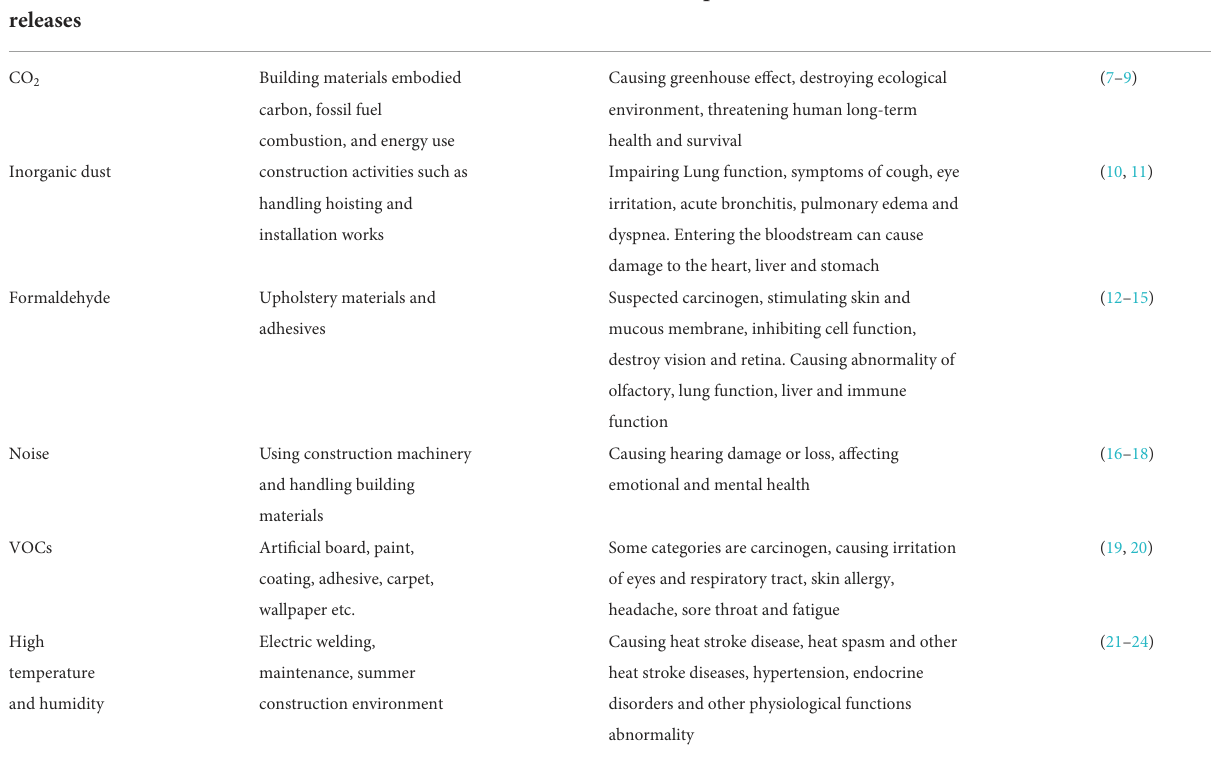
TABLE 1 Typical environmental release, sources and health impacts during